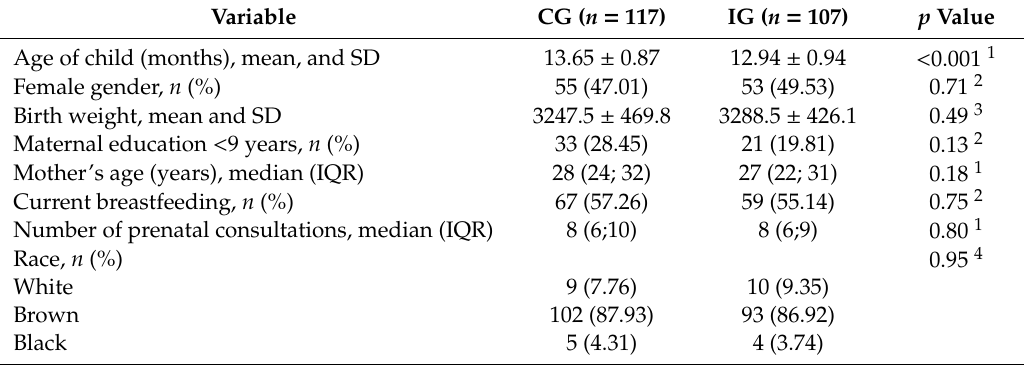
Table 1. Characteristics of children participating in the ENFAC study (Goi â nia, 2013; n = 224). Variable